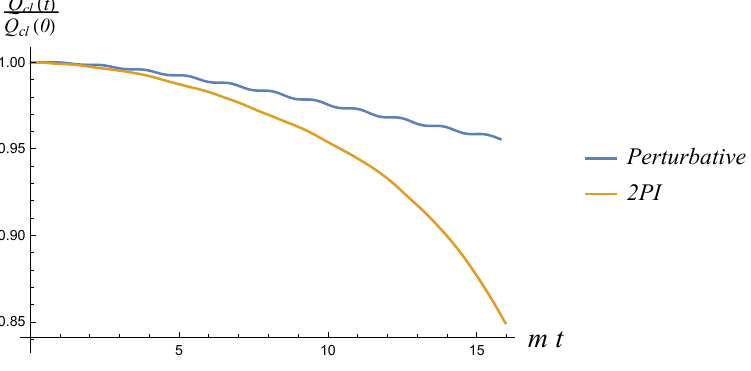
Figure 5 . Perturbative expansion compared with fully resumed 2PI for (cid:21) = m 2 and ! = 1 : 1 m . where the renormalization of the mass has already been taken into account by dropping the second diagram. Note that the choice of the time contour ensured the last term to be